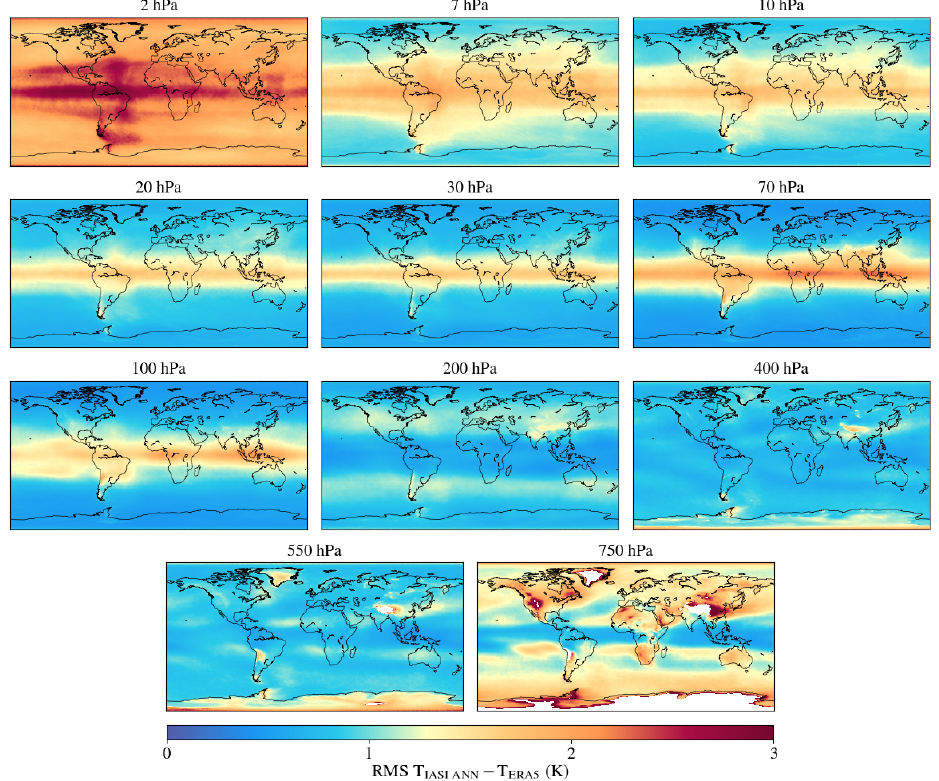
Figure 5. Root mean square of the daily differences between IASI retrievals and ERA5 on a 1 ◦ × 1 ◦ latitude–longitude grid over the period